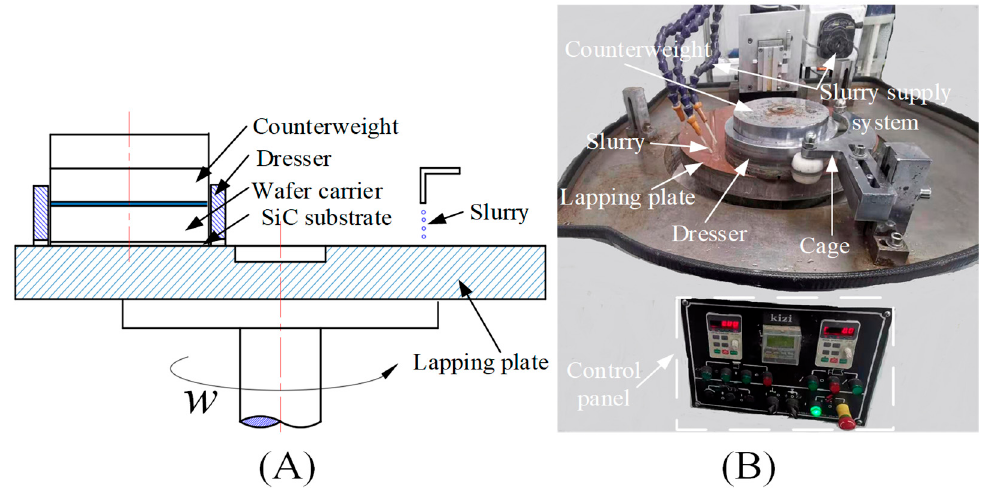
Figure 3. The principle ( A ) and device ( B ) for the lapping experiment of the SiC substrate.